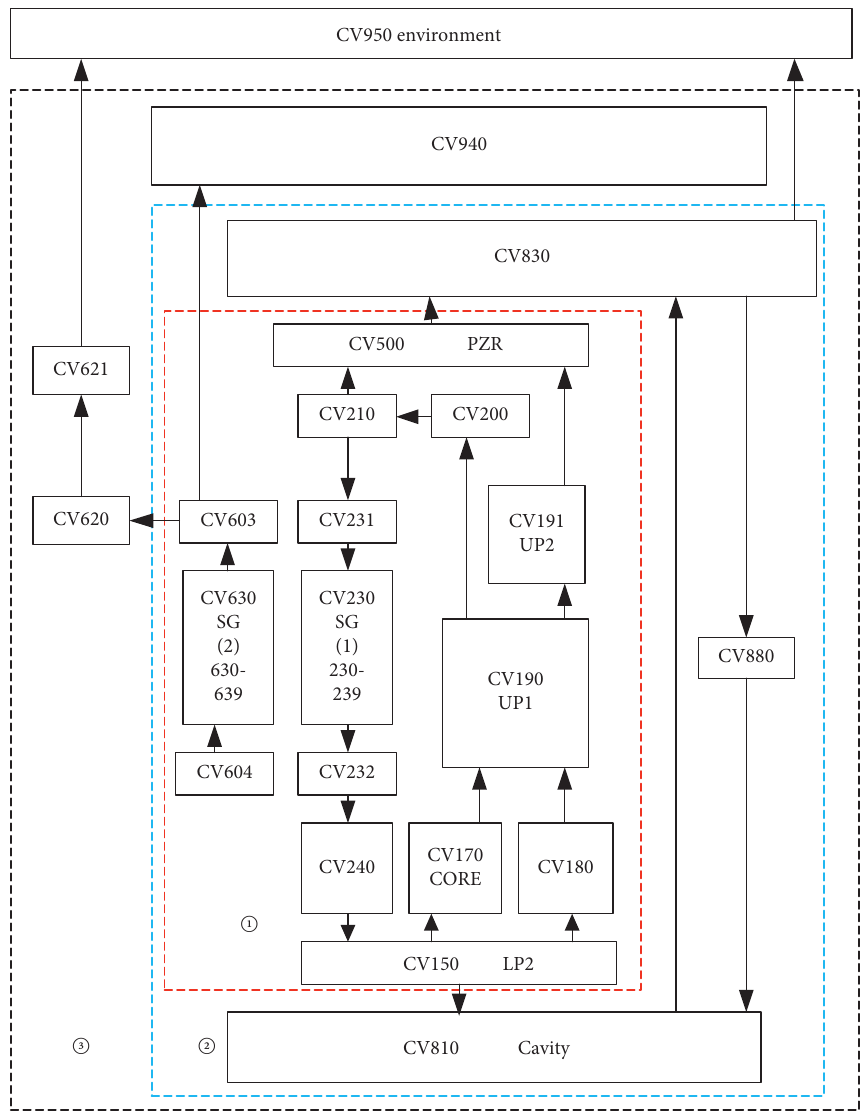
Figure 1: Nodalization of the marine reactor.